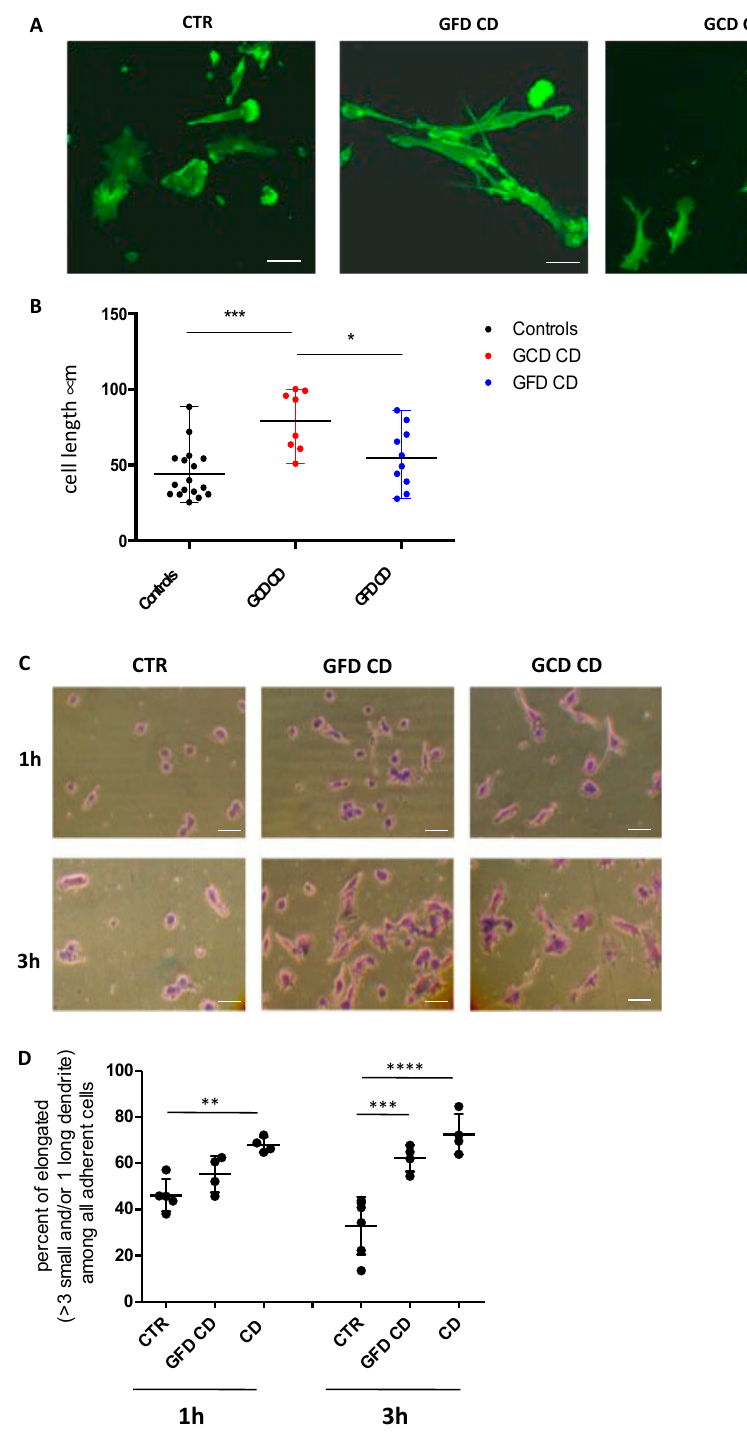
Figure 2. Elongated shape of DCs from CD patients and controls after spreading on fibronectin. ( A ) Representative images of fluorescein isothiocyanate (FITC)-conjugated phalloidin staining highlighting the actin cytoskeleton of DCs from CTR, GFD and GCD CD subjects. DCs were seeded on coverslips pre-coated with fibronectin at a concentration of 2.5 × 10 5 cells/mL. Experiments were run in duplicate. Five random pictures from each duplicate were evaluated. Scale bar = 7 µm. ( B ) The maximum stretch of at least 20 DC per patients was measured and the average extension has been calculated and plotted. Quantitative analysis of DCs length, from 17 controls, 8